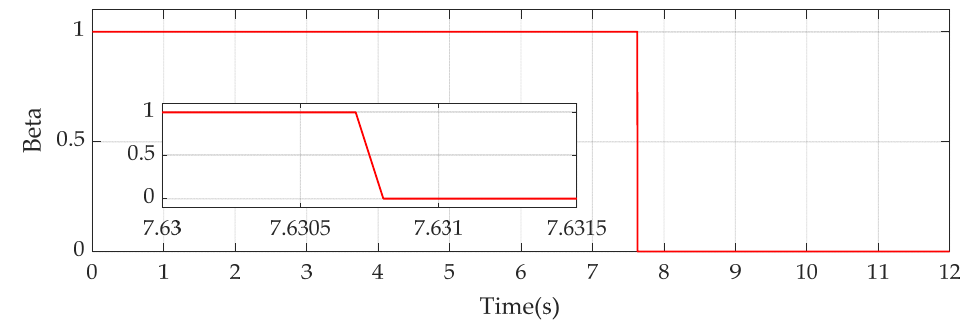
Figure 9. Response of the switched parameter β when contact-loss happens. Appl. Sci. 2019 , 9 , x FOR PEER REVIEW